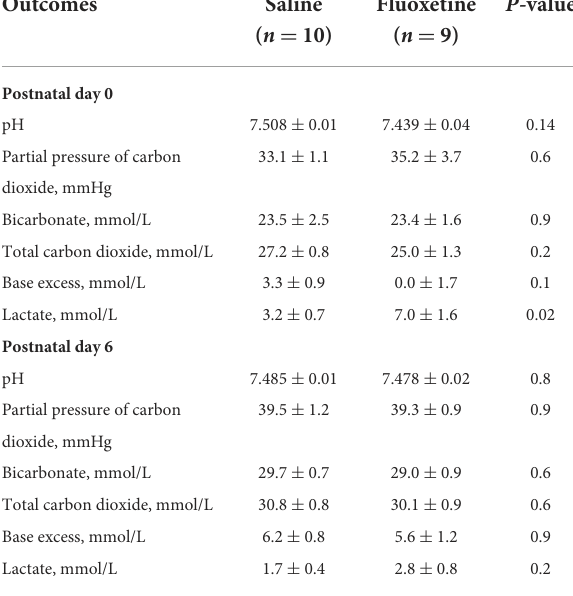
TABLE 1 Maternal acid-base